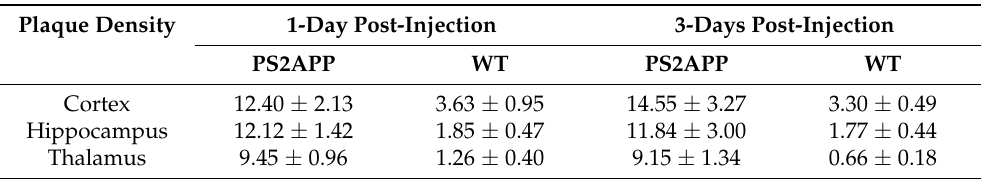
Table 1. Number of plaques detected by autoradiography after ex vivo click reaction. Data expressed as spots/mm 2 (plaque